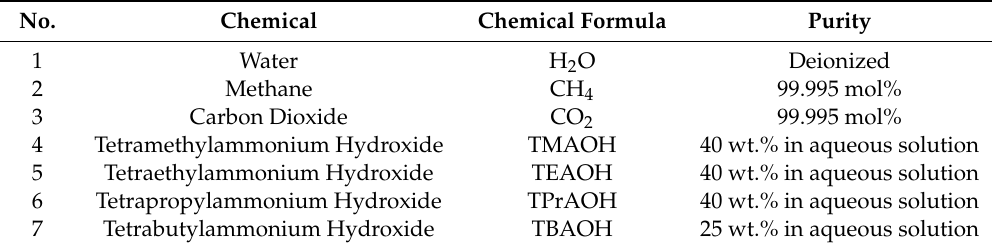
Table 1. C hemicals used in this Table 1. Chemicals used in this study.